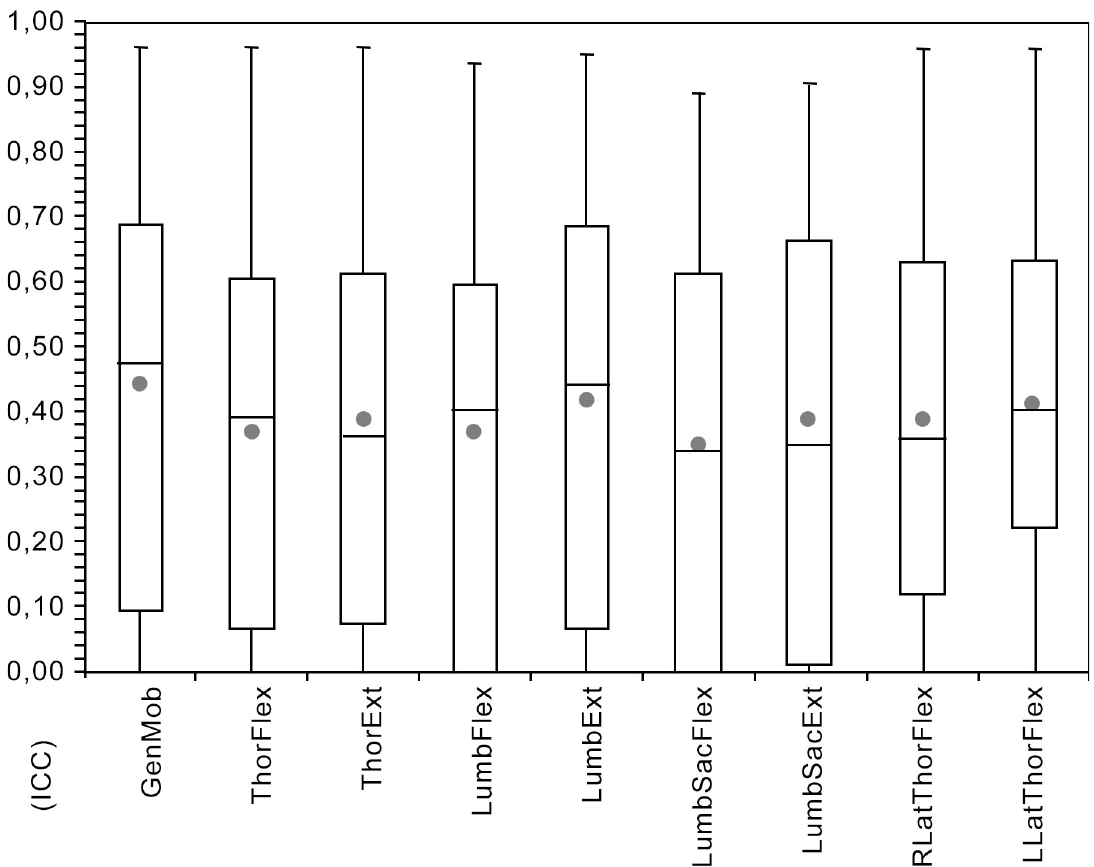
Fig 5. Box-Whisker plot (black dot: Mean, horizontal bar in box: Median) for intra-rater reliability (ICC) for general mobility (GenMob), thoracic flexion (ThorFlex), thoracic extension (ThorExt), lumbar flexion (LumbFlex), lumbar extension (LumbExt), lumbosacral flexion (LumbSacFlex), lumbosacral extension (LumbSacExt), left thoracolumbar latero-flexion (LLatThorFlex) and right thoracolumbar latero-flexion (RLatThorFlex).